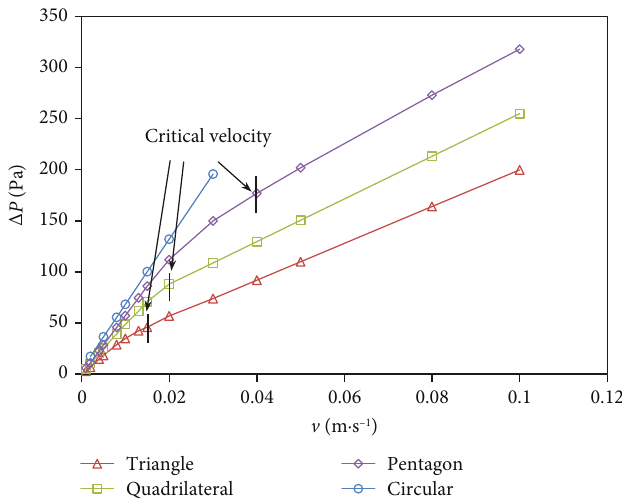
Figure 8: Steady pressure drop vs. velocity in di ff erent